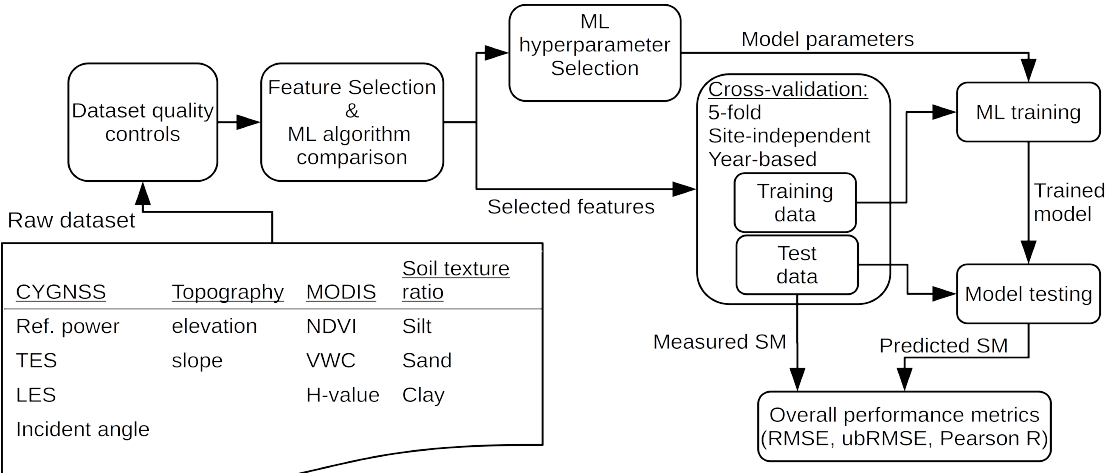
Figure 2. Flowchart of the proposed soil moisture (SM) retrieval